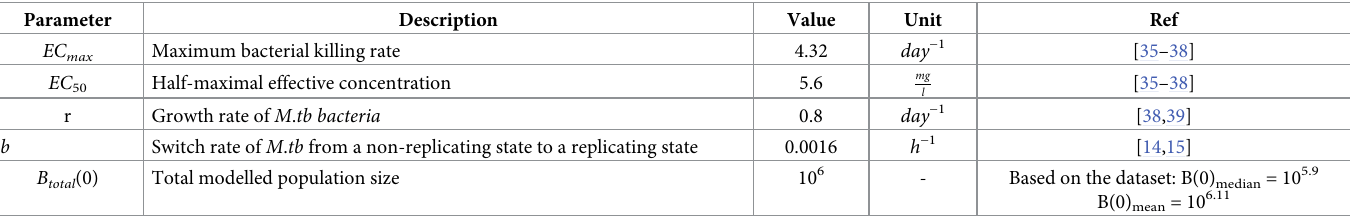
Table 1. Summary of parameters used in the mathematical models of persistence and heteroresistance.